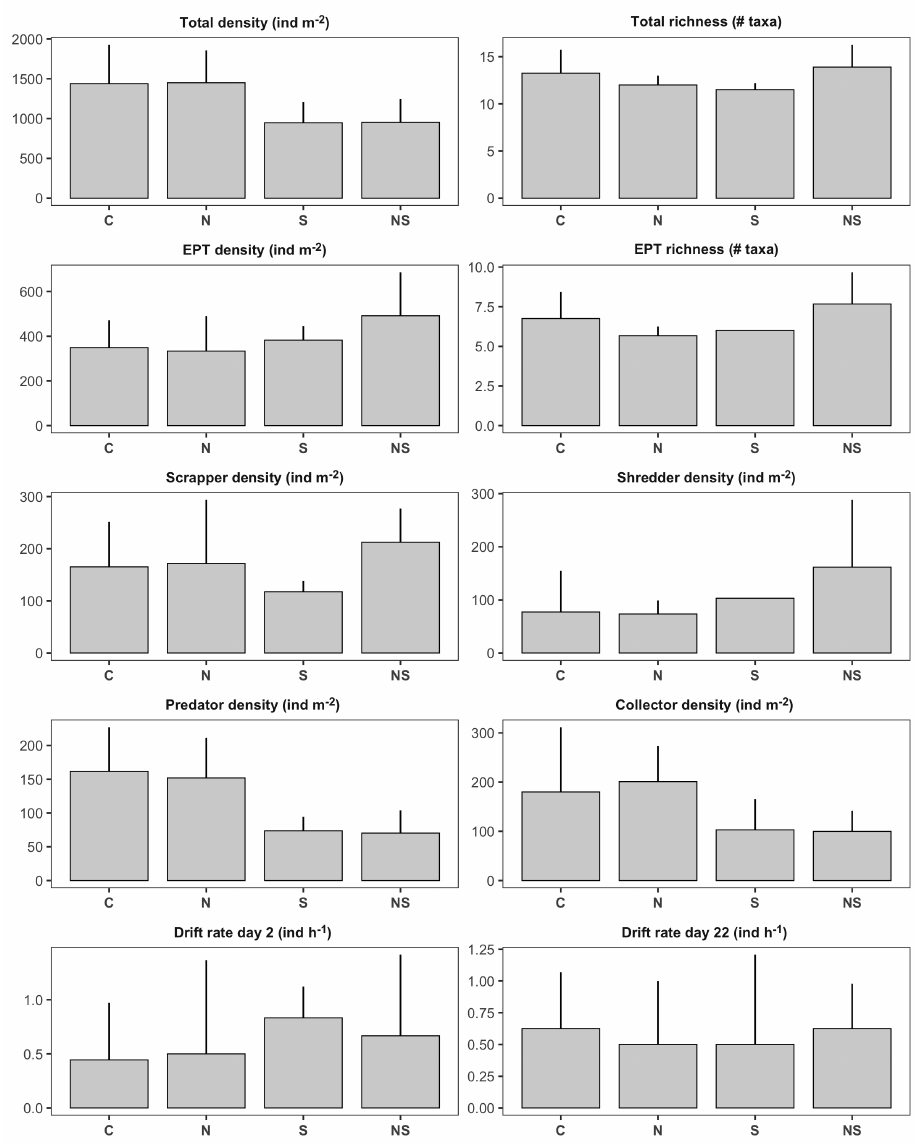
SD) of benthic invertebrate metrics in first-order Figure 3. Bar plots illustrating treatment means ( ± channels: control ( n = 9), sediment (S, n = 3), nutrients (N, n = 3), nutrients + sediment (NS, n = 9). Y-axis units for each panel are indicated in the panel’s